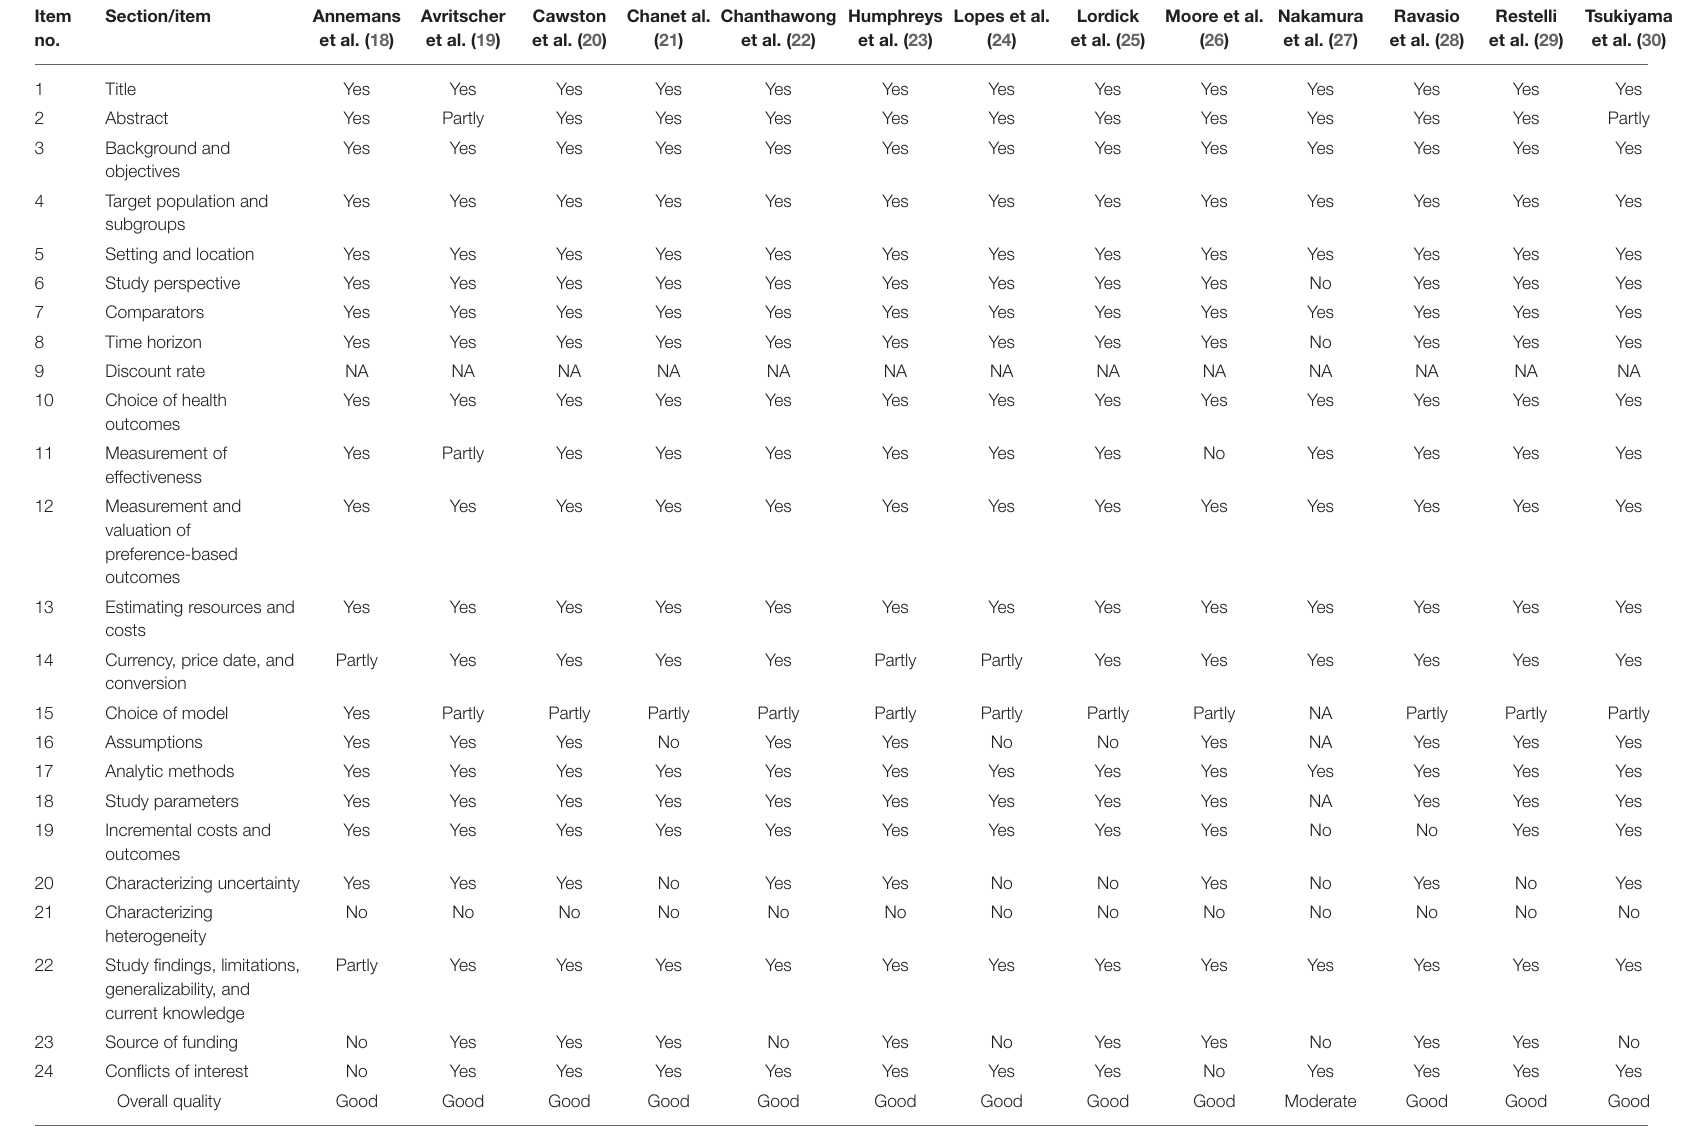
TABLE 2 | Quality of the economic evaluations (as assessed by the CHEERS statement). Item